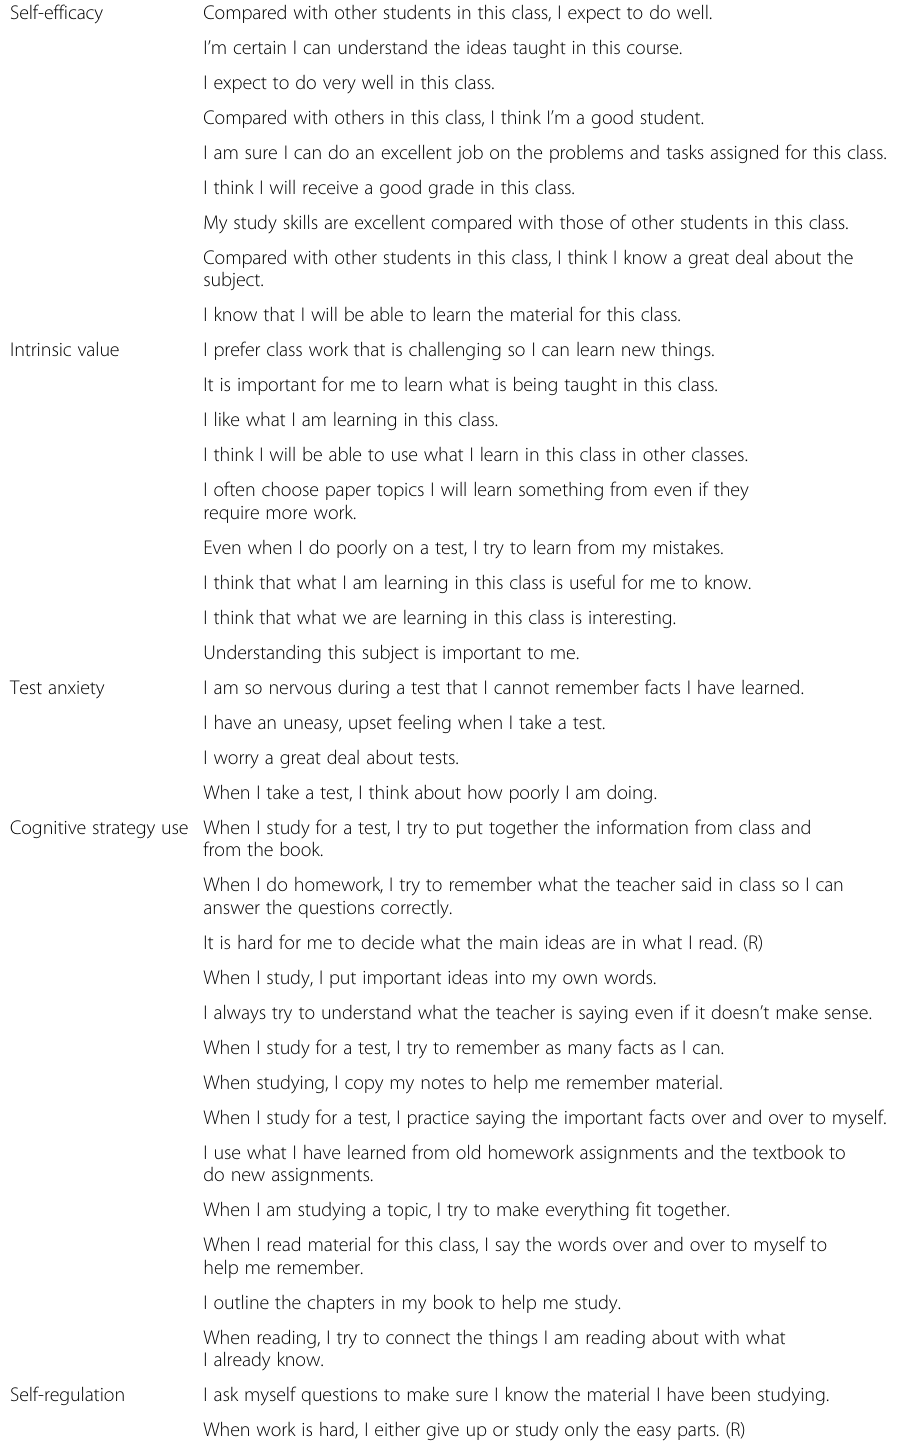
Table 7 Motivated strategies and learning questionnaire (Pintrich and DeGroot 1990) Factor Item